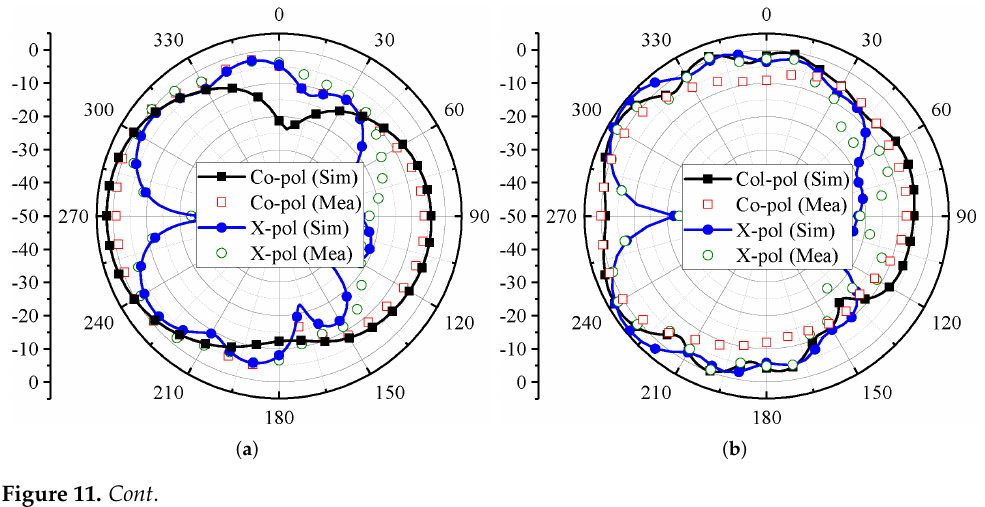
Figure 10. Modeled and actual radiation characteristics of MIMO antenna at φ = 0 ◦ for Ant 1 at ( a ) 3.4 GHz and ( b ) 4.8 GHz; Ant 4 at ( c ) 3.4 GHz and ( d ) 4.8 GHz.